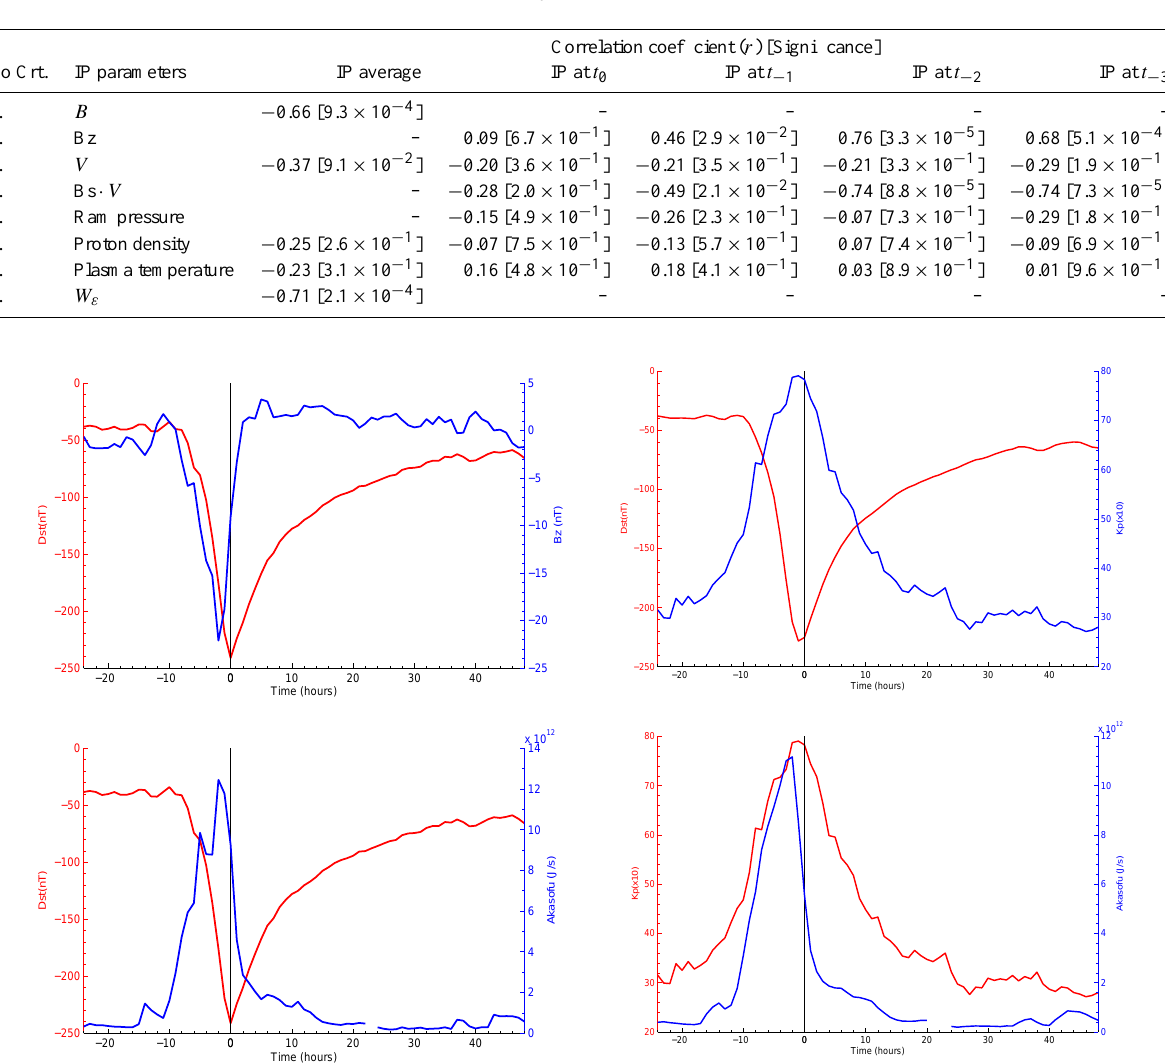
Fig. 5. Superposed epoch analysis for the hourly mean values of Dst and Bz (upper left panel), Dst and Akasofu coupling function (lower left panel) and for the 3-hourly mean values of Dst and Kp (upper right panel), Kp and Akasofu coupling function (lower right panel).